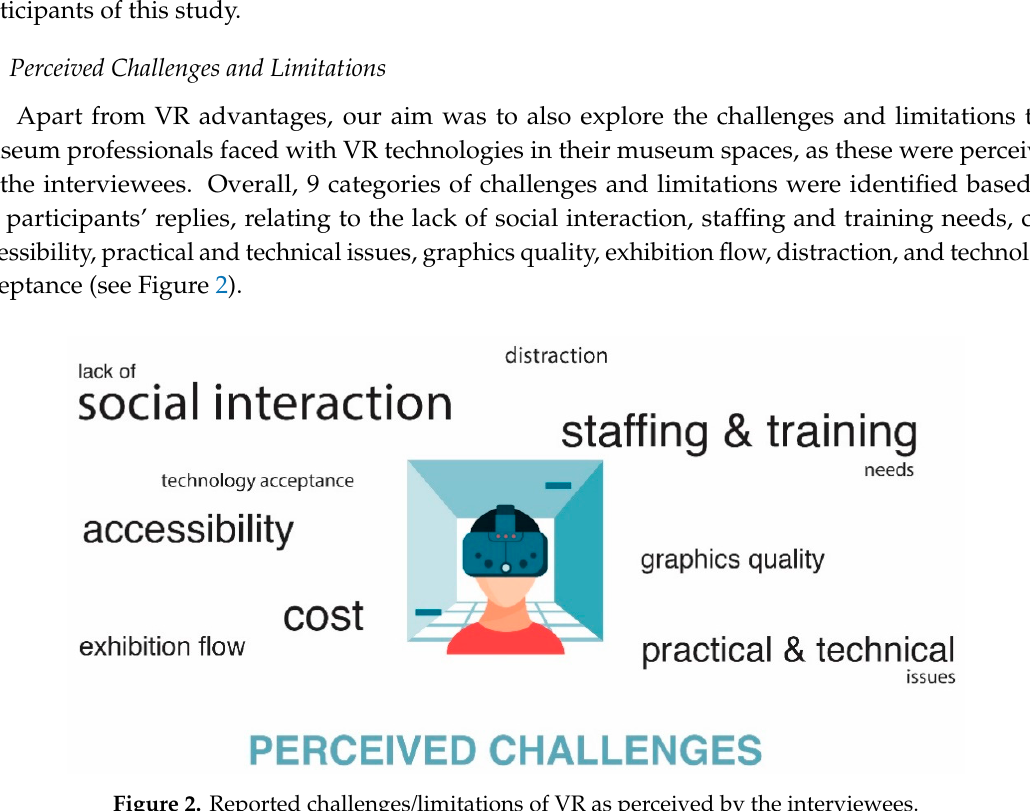
Figure 2. Reported challenges / limitations of VR as perceived by the interviewees.